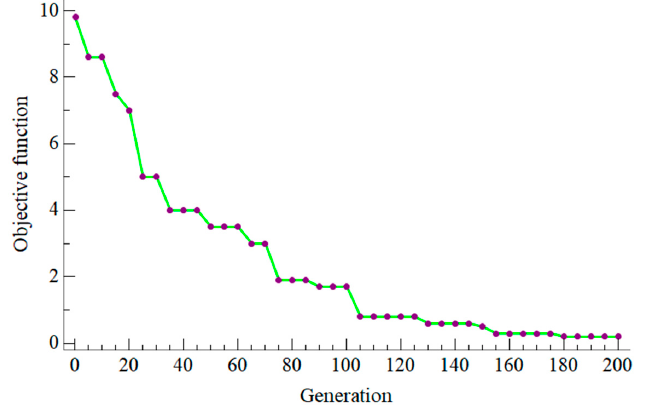
Figure 9. Convergence curve of the objective function.